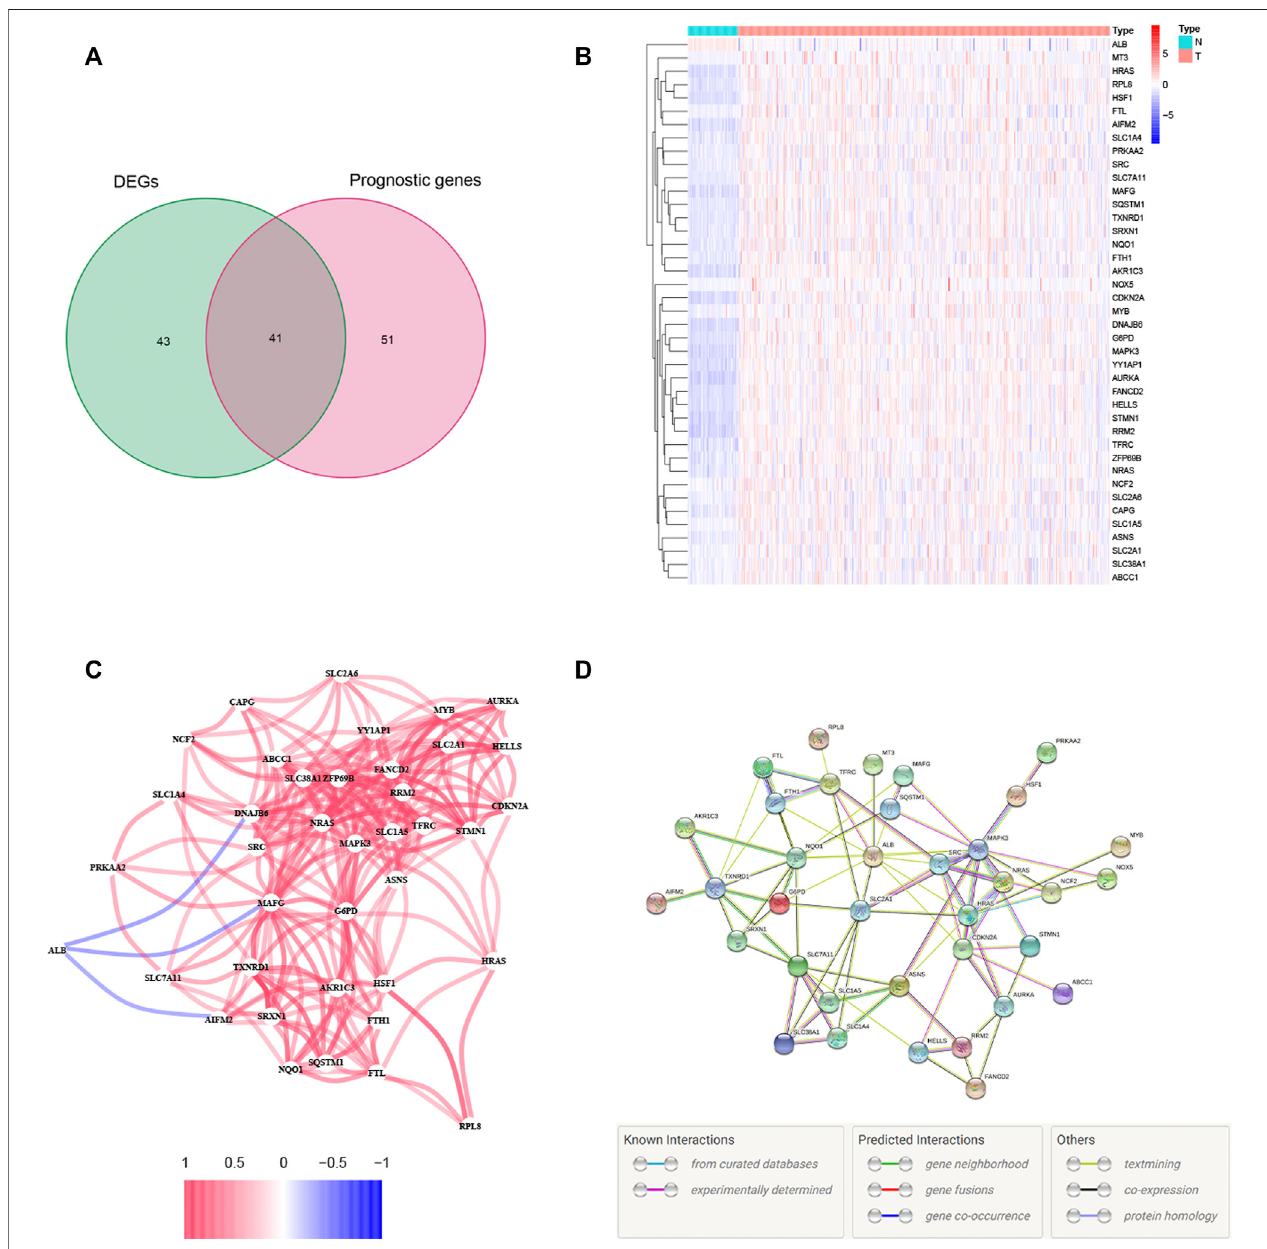
FIGURE1| Identi fi cationofthecandidateferroptosis-relatedgenes(FRGs)withdifferentialexpression andprognosticvalueintheTCGA cohort. (A) Venndiagram showing identi fi ed ferroptosis-related DEGs with prognostic value. (B) Heatmap showing the expression of the 41 overlapping genes between tumor and adjacent tissues. (C) The correlation network of candidate genes. The red line represents the positive correlation, while the blue line represents the negative correlation. (D) The PPI network indicated the interactions among the candidate genes.